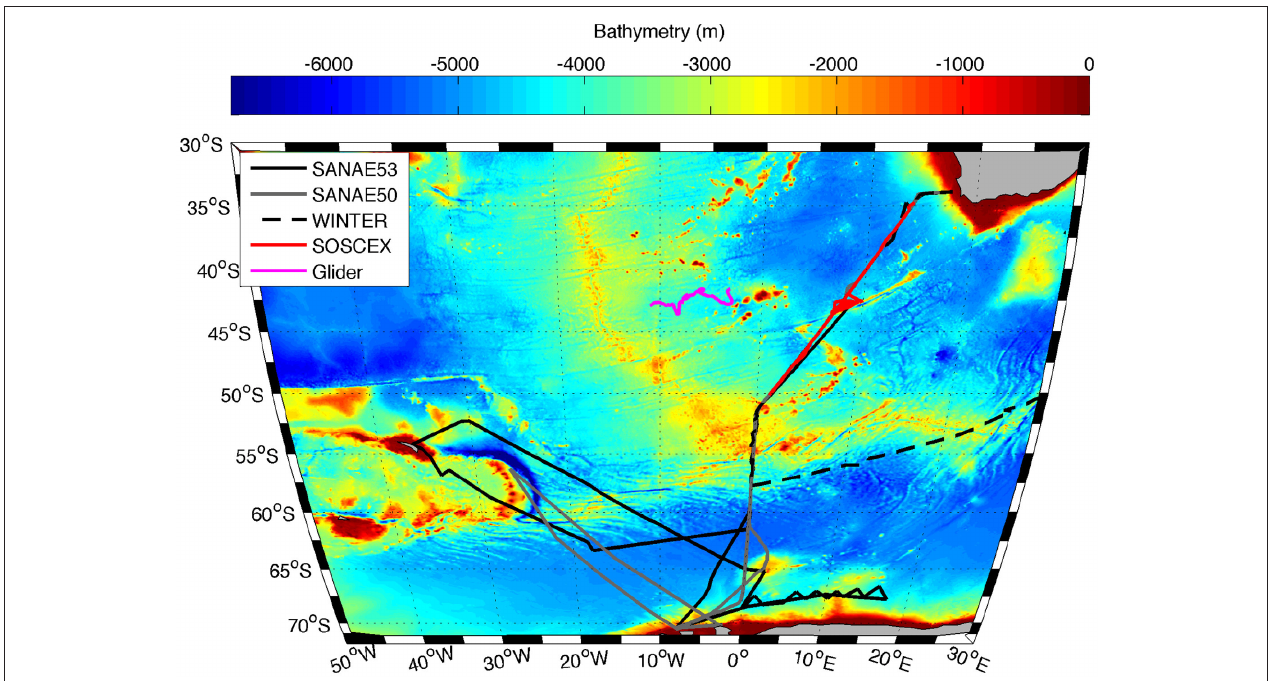
FIGURE 1 | Trajectory of the Seaglider (SG573) between 20 September 2012 and 15 February 2013 (pink line) together with cruise tracks of SANAE 53 (black solid line), SANAE 50 (grey line), WINTER (black dashed line), and SOSCEx (red line) overlaid on the bathymetry of the study